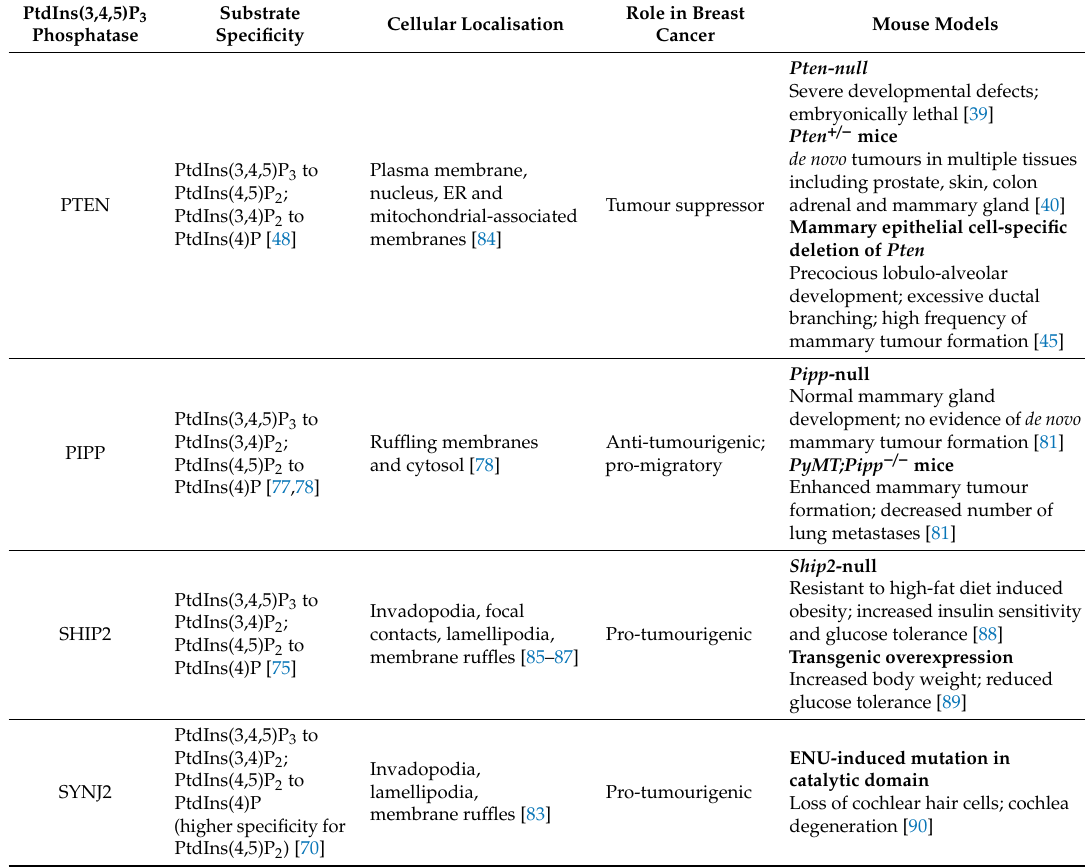
Table 1. Divergent roles of the PtdIns(3,4,5)P 3 inositol polyphosphate phosphatases in regulating breast